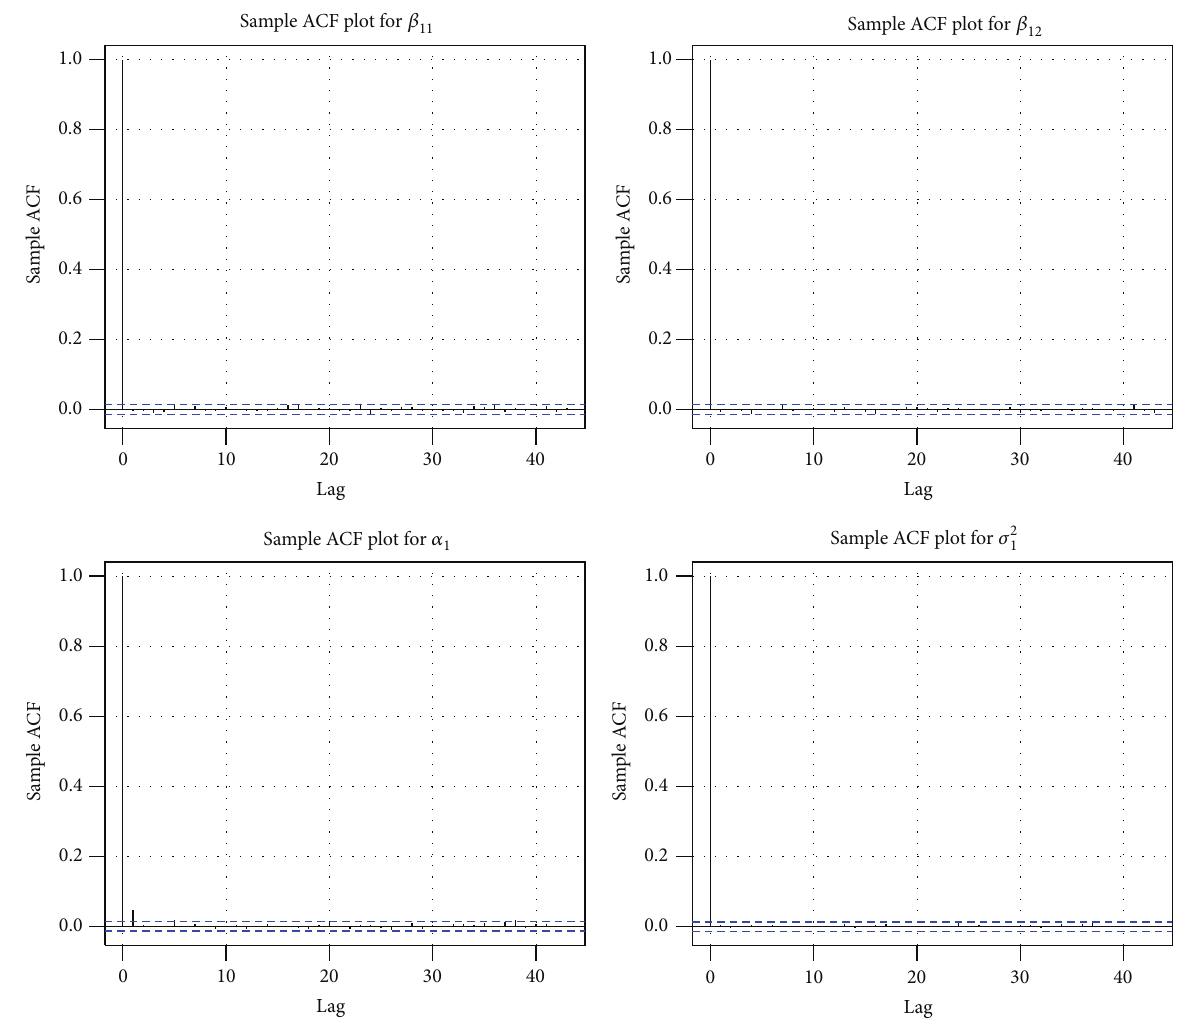
Figure 2: The sample ACF plots demonstrate that in our application a thinning procedure was not necessary. Other sample ACF plots for various parameters looked quite similar. Practitioners should check for this in their